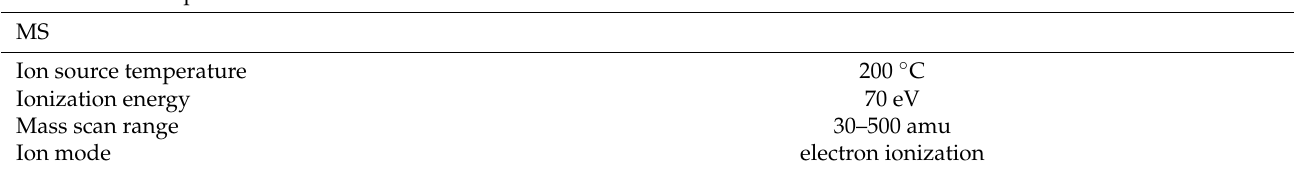
Table 6. Detailed GC-MS conditions.